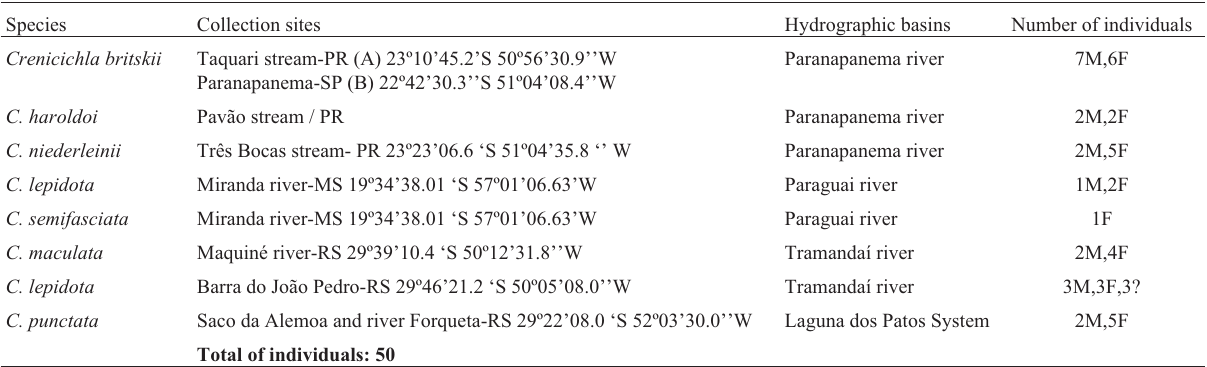
Table1 -Collectionsitesandhydrographicbasinsof Crenicichla specimensanalyzed.MS=MatoGrossodoSul;PR=Paraná;RS=RioGrandedoSul